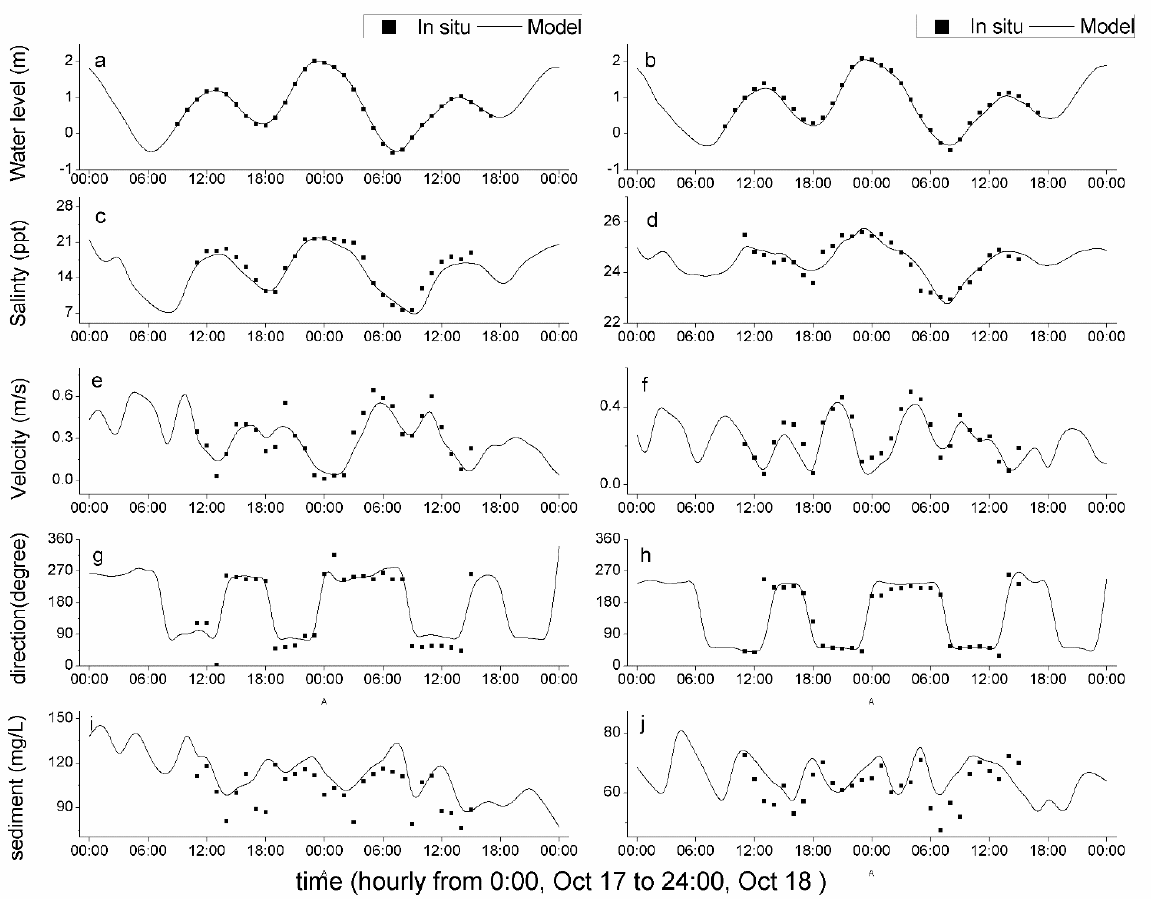
Figure 3. Validation of model results. ( a ) the water level at Tsim Bui Tsui (TBT); ( b ) water level Dong Jiao Tou (DJT); ( c ) the depth-averaged salinity at S5; ( d ) the depth-averaged salinity at S7; ( e ) the depth-averaged current velocity at S5; ( f ) the depth-averaged current velocity at S7; ( g ) the current direction at S5; ( h ) the current direction at S7; ( i ) the sediment concentration at S5; ( j ) the sediment concentration at